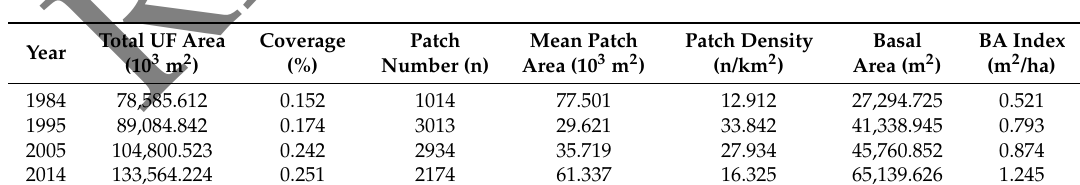
Figure 7. Spatio-temporal patterns of UF in Changchun during 1984–2014. Table 2. Summary of UF attributes within the study area in the City of Changchun,